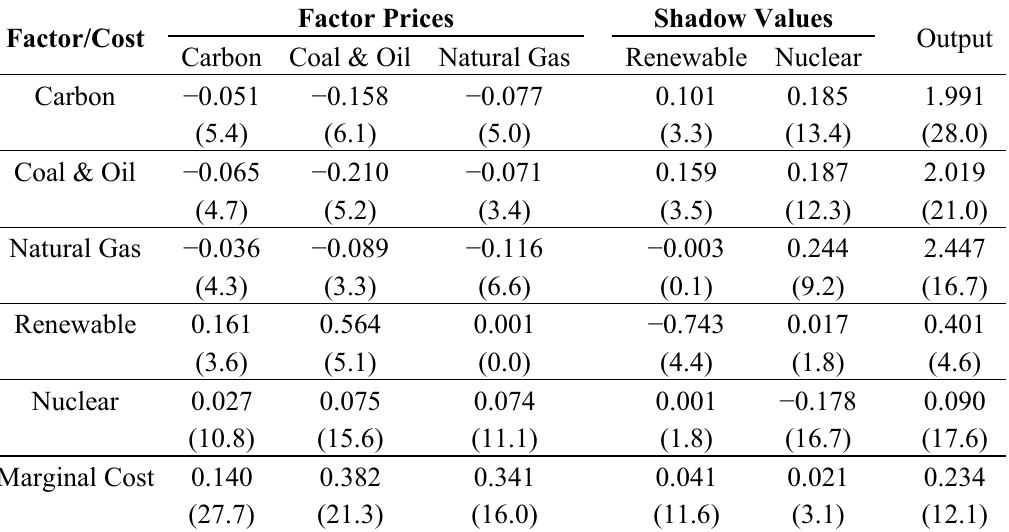
Table 5. Elasticities of demand and marginal cost (asymptotic t -ratios in